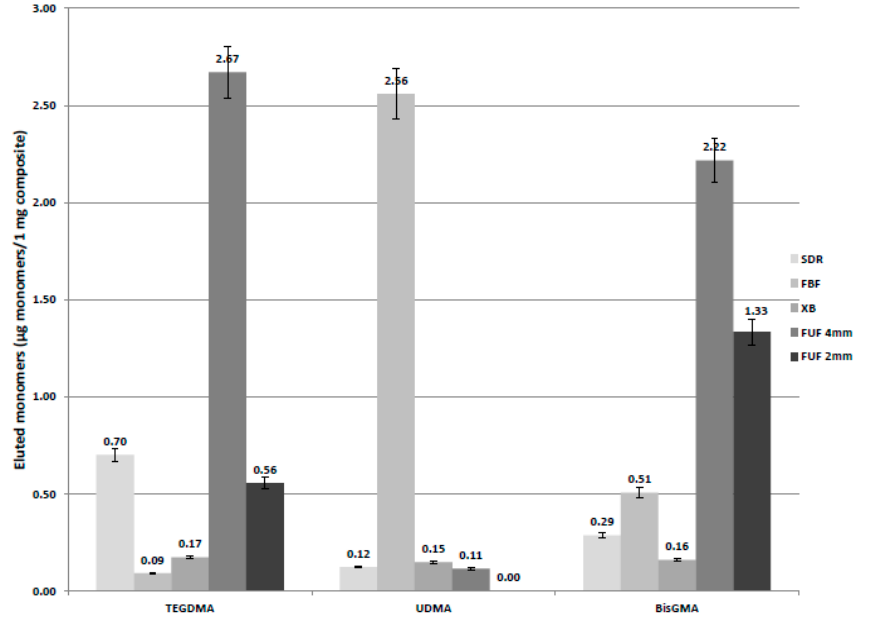
Figure 3. Amount of eluted monomers from bulk-fill and conventional flowable composites. (Abbreviations: SDR, SureFil SDR Flow in a 4-mm layer thickness light cured for 20 s; FBF, Filtek Bulk Fill in a 4-mm layer thickness light cured for 10 s; XB, X-tra Base in a 4-mm layer thickness light cured for 10 s; FUF 4 mm, Filtek Ultimate Flow in a 4-mm layer thickness light cured for 20 s; FUF 2 mm, Filtek Ultimate Flow in a 2-mm layer thickness light cured for 20 s).